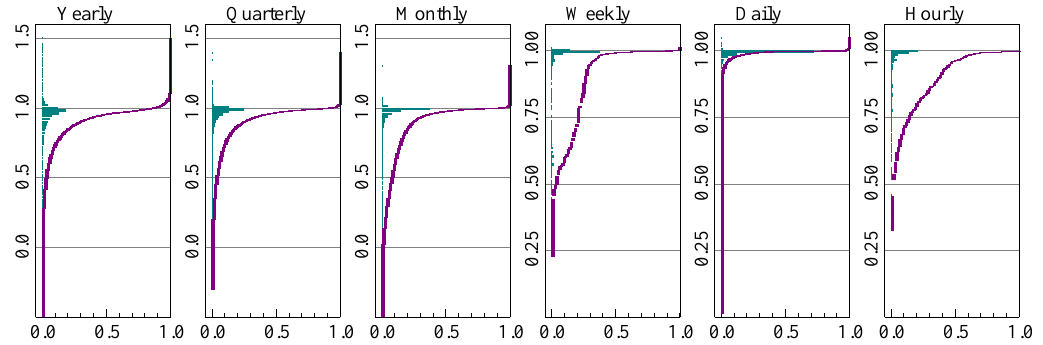
Figure 3. Distribution of autoregressive coefficient for each frequency of